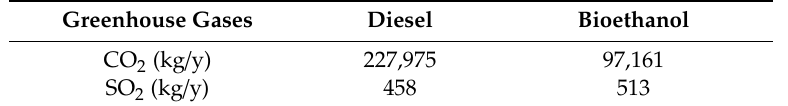
Table 8. Emission comparison between fossil diesel and experimented bioethanol combustion.